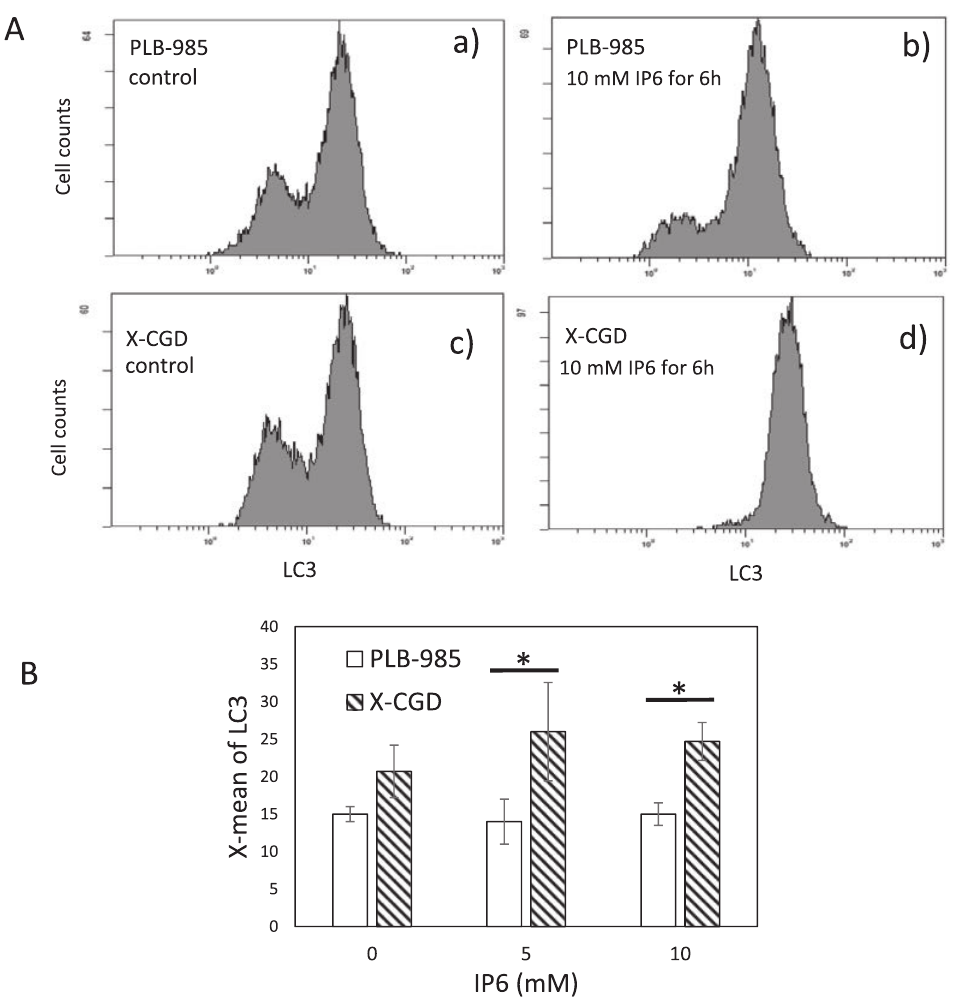
Figure 4 Detection of LC3 levels with flow cytometer A) Typical flow cytometry histogram of cells treated with 10 mM inositol hexaphosphate. Each histogram shows the LC3 levels (measured as signal intensity of the secondary antibody IgG-fluorescein isothiocyanate) on the X-axis versus cell count on the Y-axis. B) The average value (X-mean) of LC3 level calculated from the flow cytometry of the cells treated with 5 and 10 mM inositol hexaphosphate for 6 h obtained from three independent experiments. *P<0.05 (Student’s t